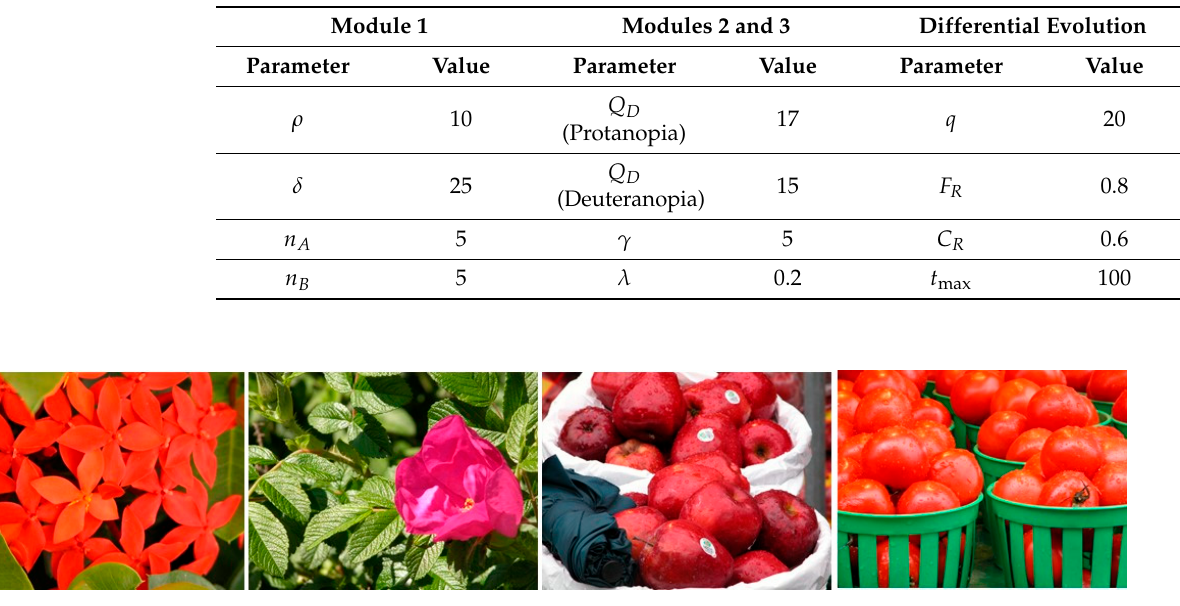
Figure 4. A sample of four images included in the Flowers and Fruits data sets taken from the McGill’s calibrated color image database.